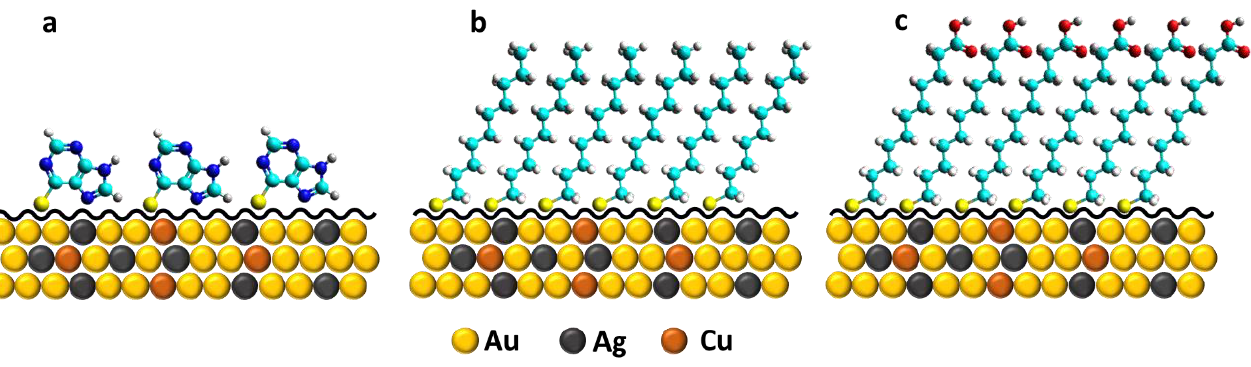
Figure 6. Electrochemical impedance spectra. Experimental Bode plot data of a square plate of 18K gold alloy (red circles) in ( A ) 10 mM HClO 4 and ( B ) 0.1 NaOH. Experimental data (red circles) are fitted to a [R(QR)] equivalent circuit (blue lines). A simulated RC equivalent circuit is included for comparison (black lines). E = −0 .3 V. Schemes of the RC and [R(QR)] circuits are depicted.